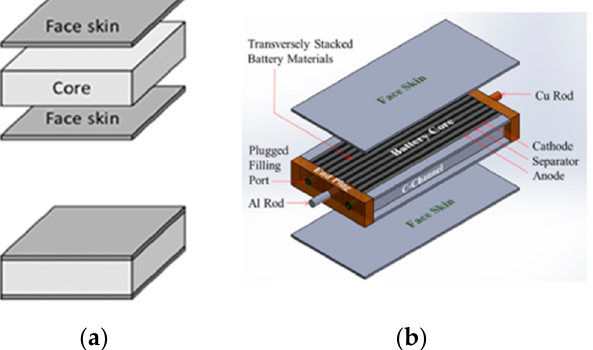
Figure 39. Schematic concept of sandwich structural battery: ( a ) sandwich panel with a foam core and two face skins; ( b ) sandwich panel with battery core and two face skins [192].